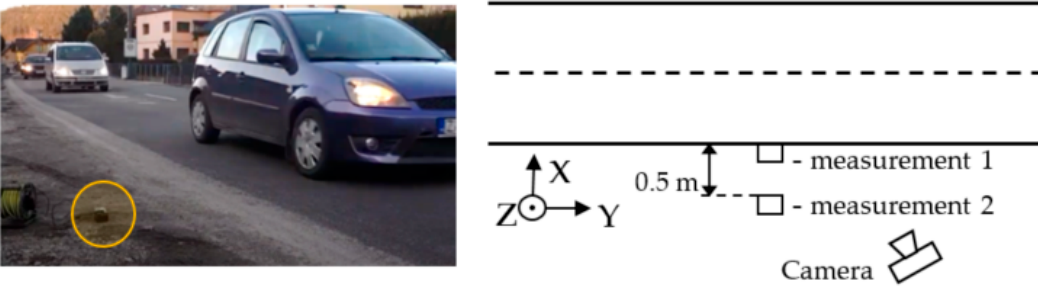
Figure 3. Sensor placement and view of the measuring set. During the first measurement, 88 vehicles were recorded, of which 74 were cars, nine vans, three buses and two trucks. In the second measurement, there were 94 vehicles, of which 86 were cars, seven vans and one truck. Based on the camera recording, each vehicle was assigned a type and time of passage (accurate to 1/24 s).